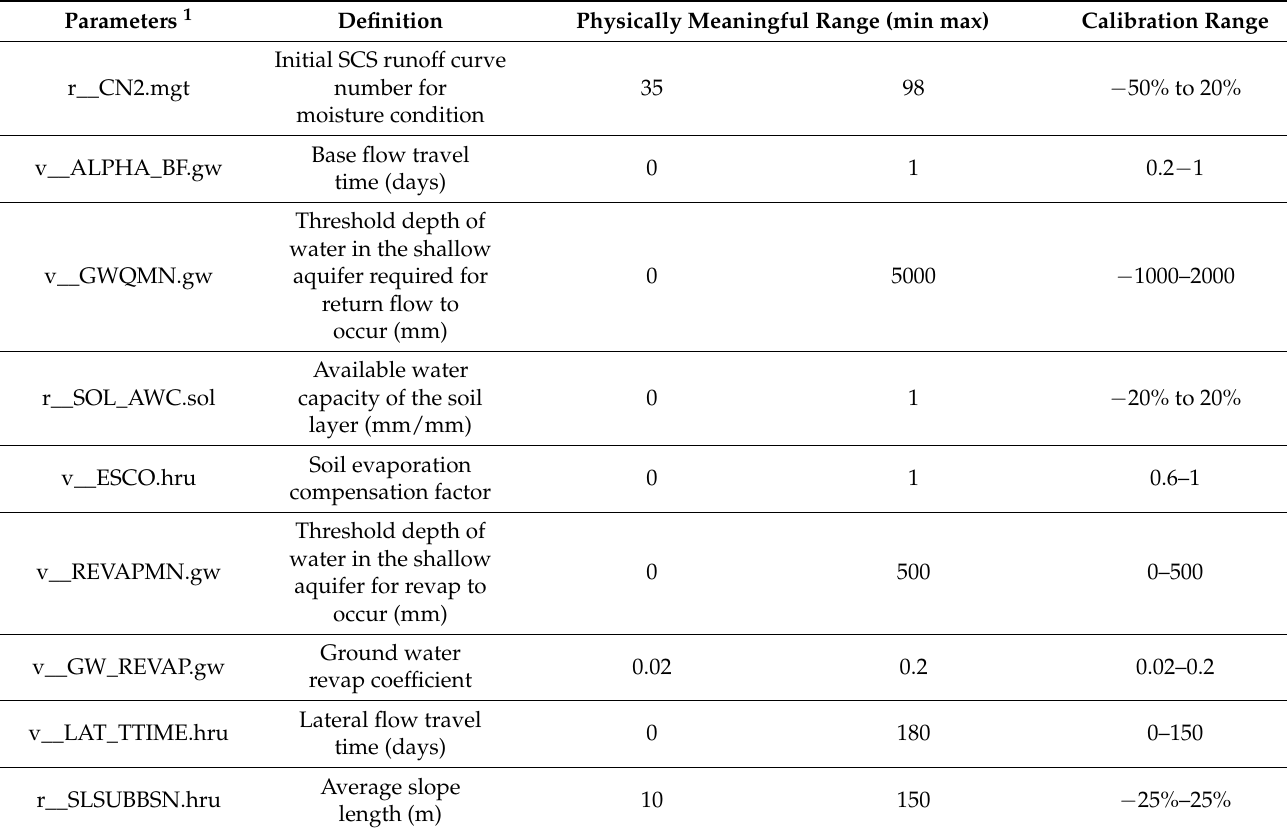
Table 3. Parameters used in the calibration process.